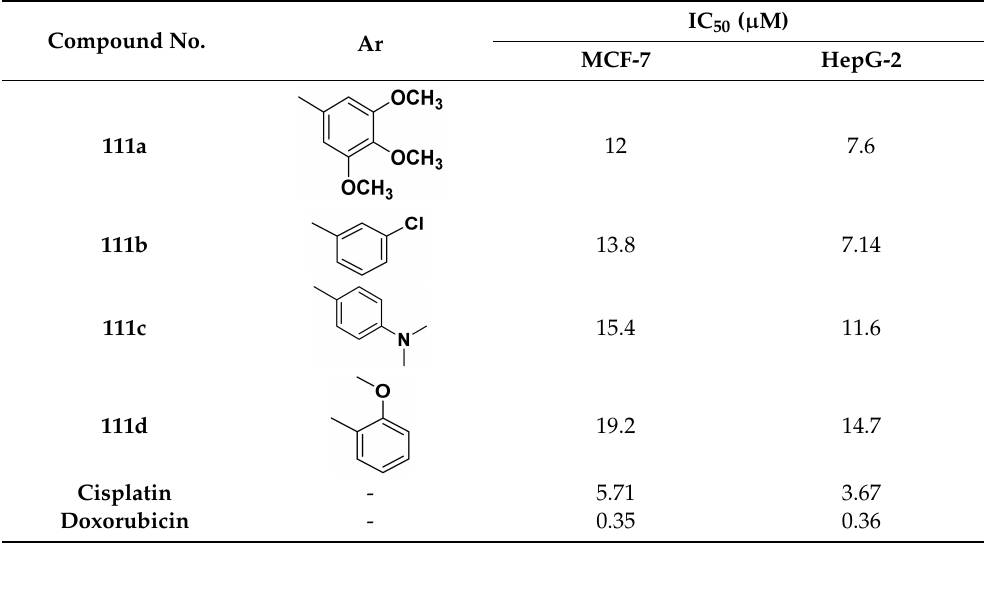
Table 93. In vitro cytotoxic activities of chalcone-based phenothiazine hybrid compounds [ 111 ( a – d ), 111 ( a )].